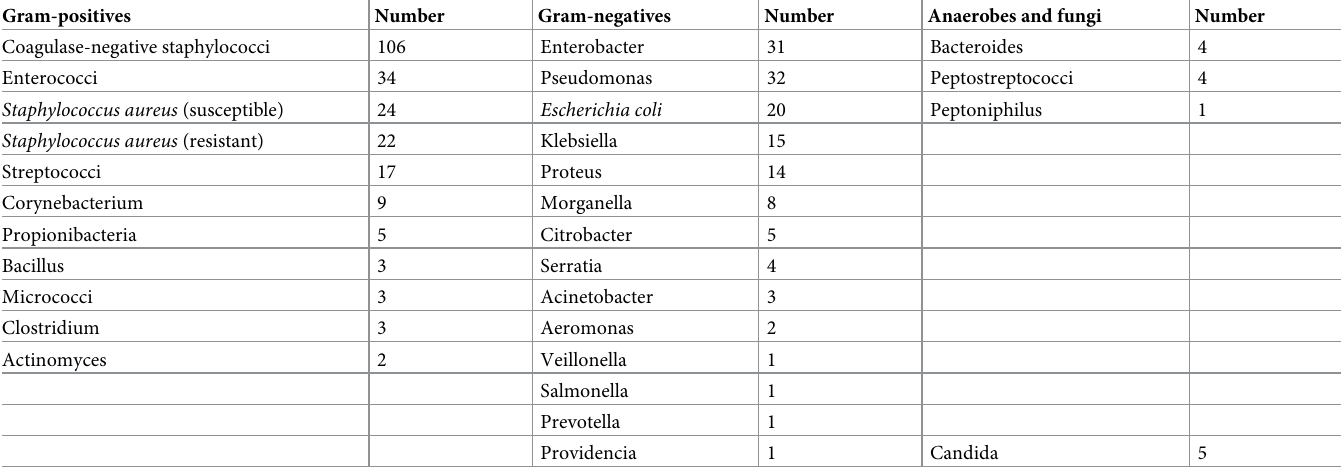
Table 4. New pathogens and new orthopaedic surgical site infections during current antibiotic treatment (n = 273). Gram-positives